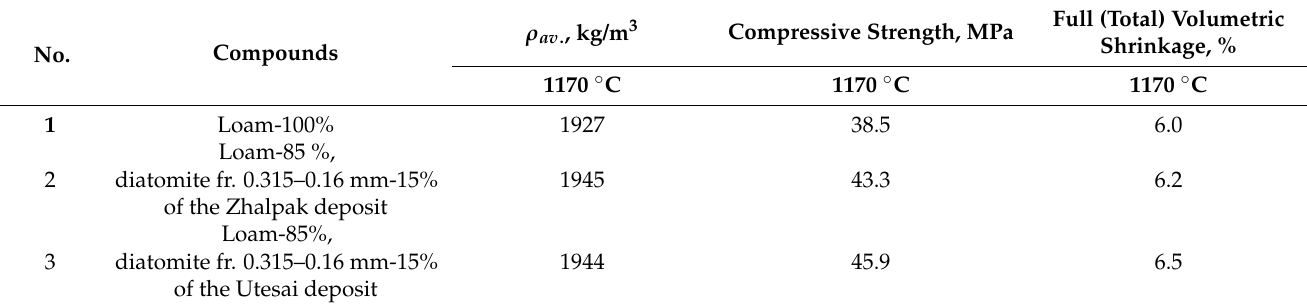
Table 3. Compounds and properties of samples based on loam and diatomite.